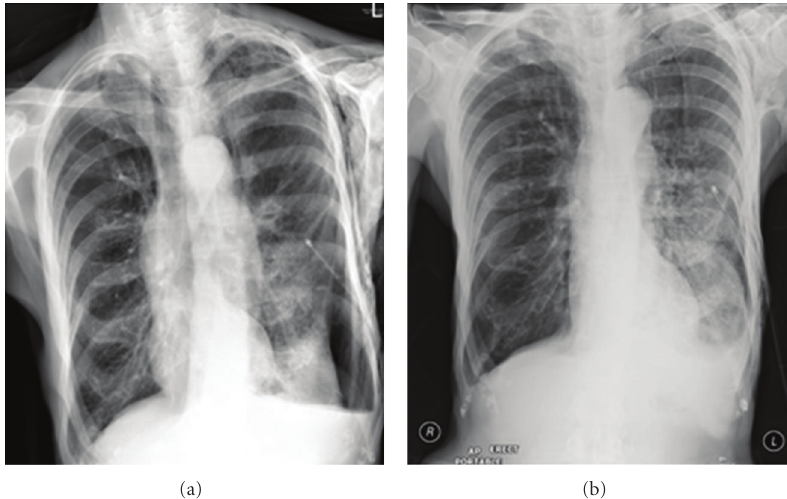
Figure 27: Reexpansion pulmonary edema (REPE) is a rare complication occurring after the insertion of a chest tube for pneumothorax or pleural e ff usion. REPE can appear on the ipsi- or contralateral side, can be bilateral and can even be asymptomatic. The case illustrated developed an ipsilateral REPE over a period of 6 hours following placement of a chest drain for a pneumothorax. The patient stabilized under continuous oxygen (12L/min via a nonrebreather facemask) with his oxygen saturation steadily increasing. The patient required no further treatment. REPE is a serious complication associated with mortality of approximately 20%. Also, see Figure 27.